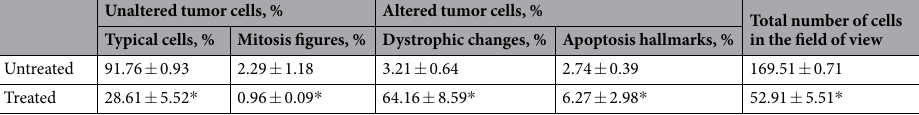
Table 2. Histological analysis of tumors treated with cisplatin. * p ≤ 0.05, compared with untreated tumors. Mean ± SD, n = 6 tumors. The percentage of cells with different morphological signs was calculated in 5 randomly selected fields of view for each tumor. The data were combined from HeLa and HeLa-SypHer2 tumors.